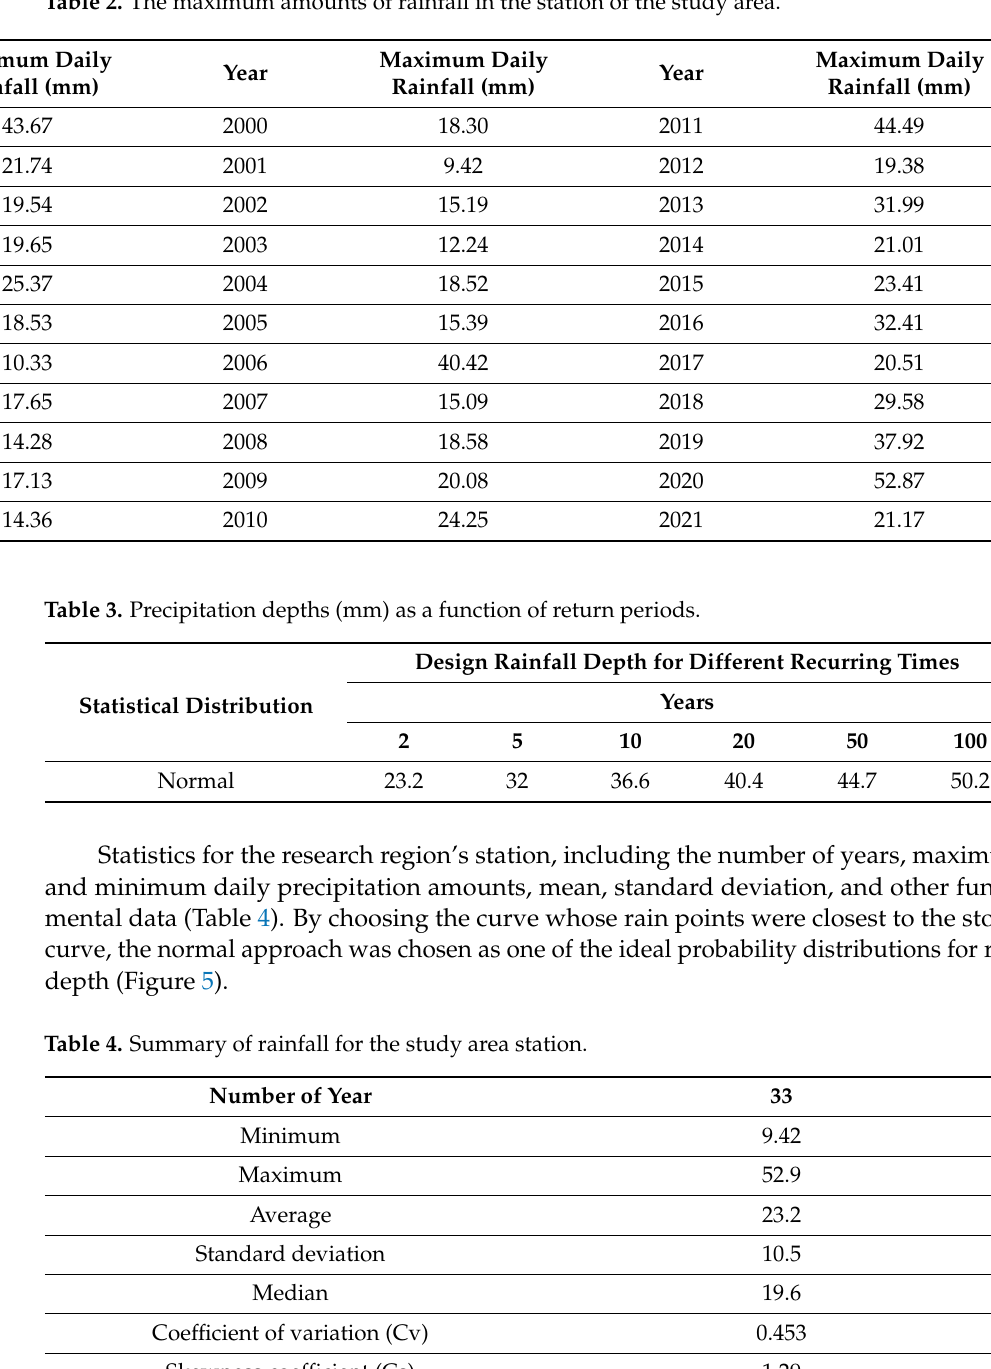
Table 2. The maximum amounts of rainfall in the station of the study area.